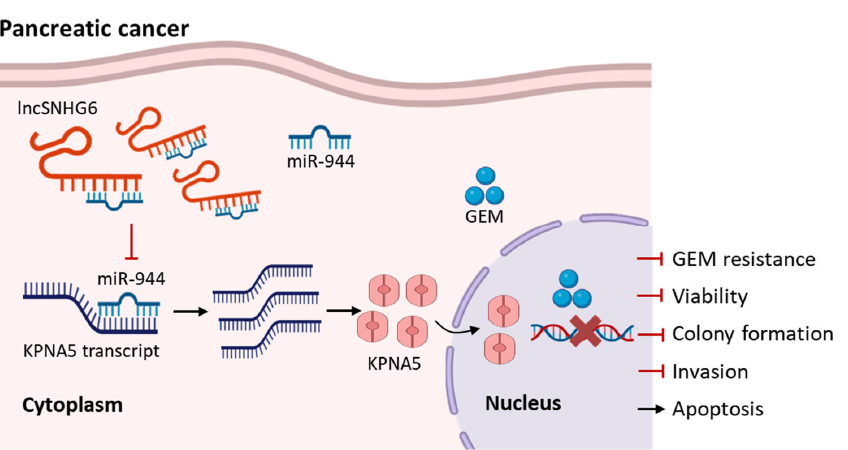
Figure 6. Schematic illustration of the role of LncRNA SNHG6 /miR ‐ 944/KPNA5 in overcoming GEM resistance in PC. LncRNA SNHG6 is highly expressed to sponge and mediates silencing of miR ‐ 944, which leads to the elevated expression of KPNA5 protein. Activation of LncRNA SNHG6/miR ‐ 944/KPNA5 axis increases the sensitivity of PC to GEM, thus inducing cell apoptosis and reducing cell viability and colony formation and invasion during GEM treatment. Loss of LncRNA SNHG6 causes miR ‐ 944 elevation and KPNA5 reduction, which will result in GEM resistance of PC.